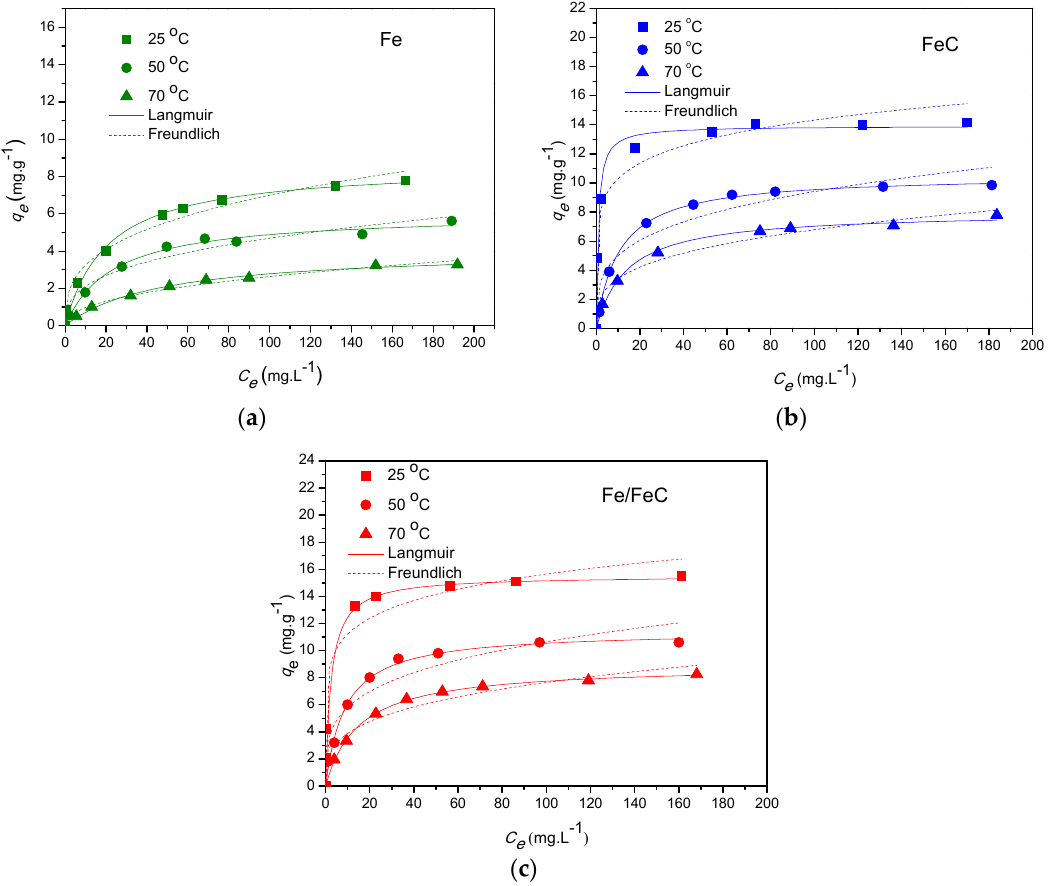
Figure 7. Langmuir and Freundlich plots at different temperatures for Acid Red 66 adsorption on ( a ) Fe, ( b ) Fe / C and ( c ) Fe / FeC.